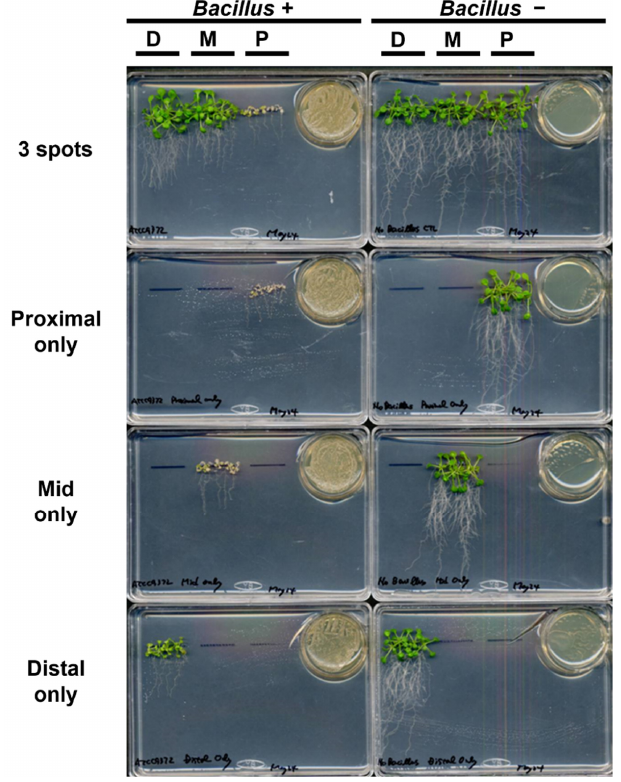
Figure A2. Growth alteration of the Arabidopsis seedlings upon exposure to VOCs of Bacillus culture was affected by the seedlings being relatively closer to the source of the VOCs. Either fifteen (3 spots) or five (either proximal, mid, or distal only) Arabidopsis seedlings were exposed to Bacillus VOCs for 14 days. When five Arabidopsis seedlings were grown in the mid position, the growth of the seedlings were severely inhibited compared with the case when the Bacillus was not co-cultured. Likewise, when grown only in the distal position, the inhibition of the Arabidopsis seedlings growth was evi- dent compared with the no Bacillus control. Moreover, the growth of the seedlings grown either in the proximal, mid or distal only positions was severely inhibited by the Bacillus VOCs compared with the case when fifteen Arabidopsis seedlings were grown (3 spots). D: distal; M: mid; P: proximal.